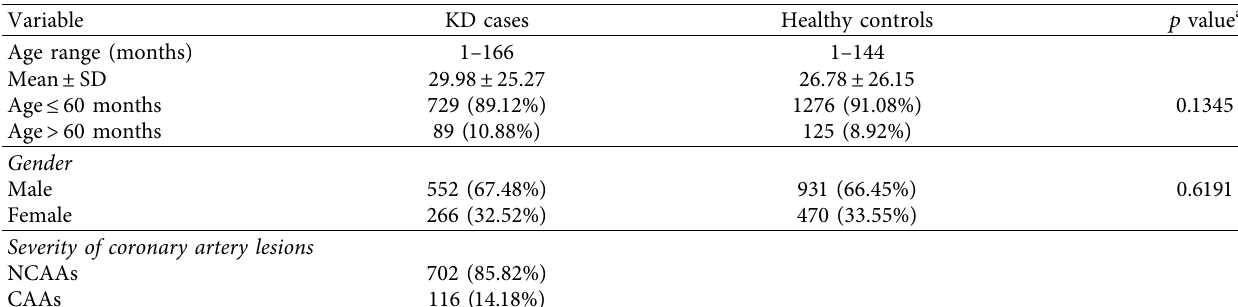
Table 2: Baseline and clinical characteristics in Kawasaki disease cases and healthy